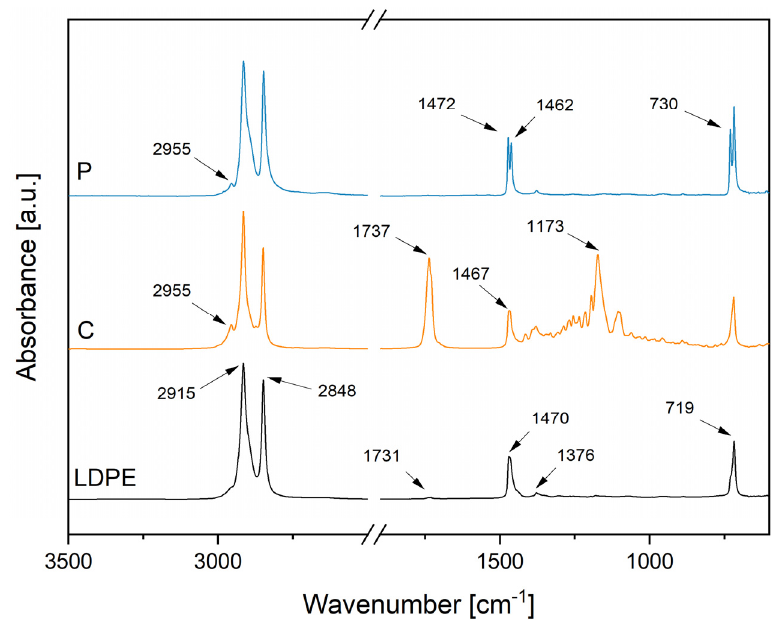
Figure 3. FTIR spectra of feedstock powders with characteristic absorbance peaks. LDPE, C, and P refer to low-density polyethylene, fully hydrogenated cottonseed oil, and paraffinic wax powders, respectively.